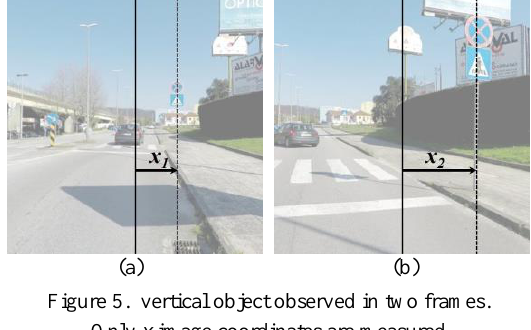
Figure 5. vertical object observed in two frames. Only x image coordinates are measured Two lines (azimuths  1 and  2 ) are defined and the intersection point, P , is calculated (figure 6).